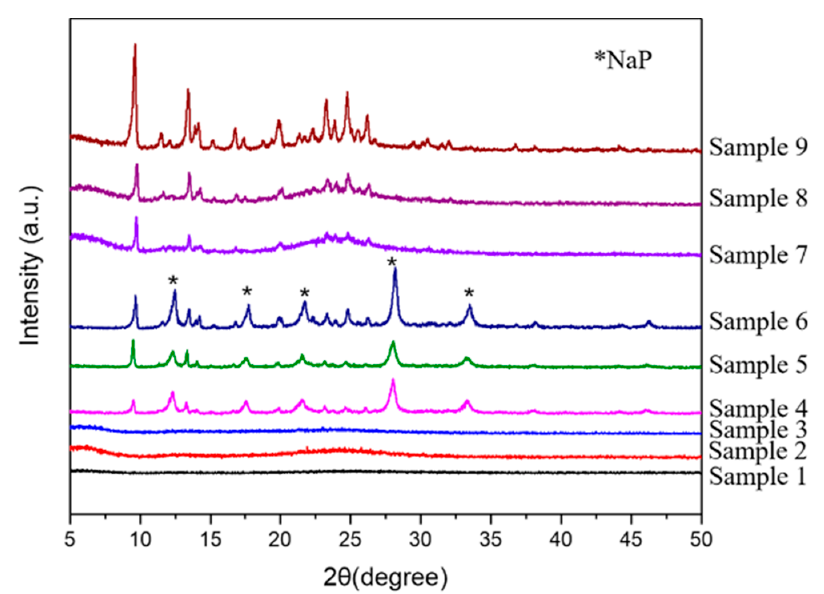
Figure 6. XRD patterns of Sample 1–9.